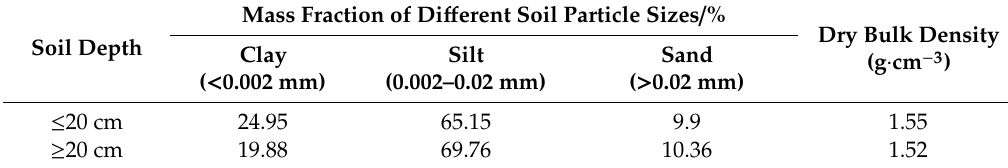
Table 1. Main physical parameters of soils.